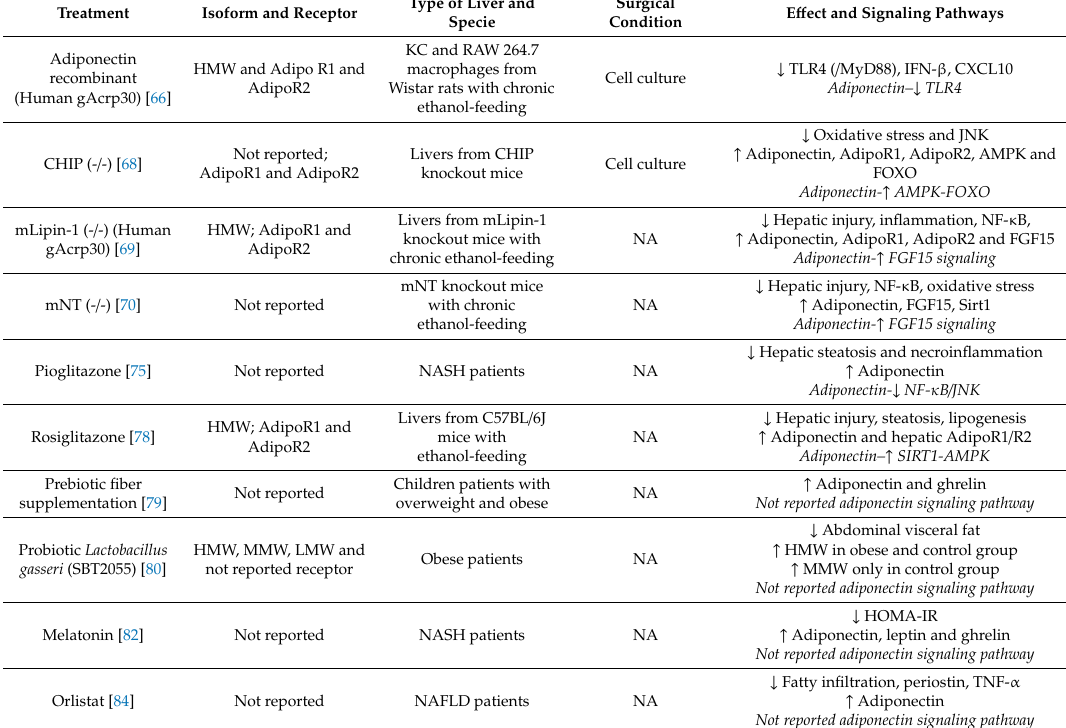
Table 2. E ff ect of strategies that regulate adiponectin in liver diseases in the absence of surgery in studies from 2010 to